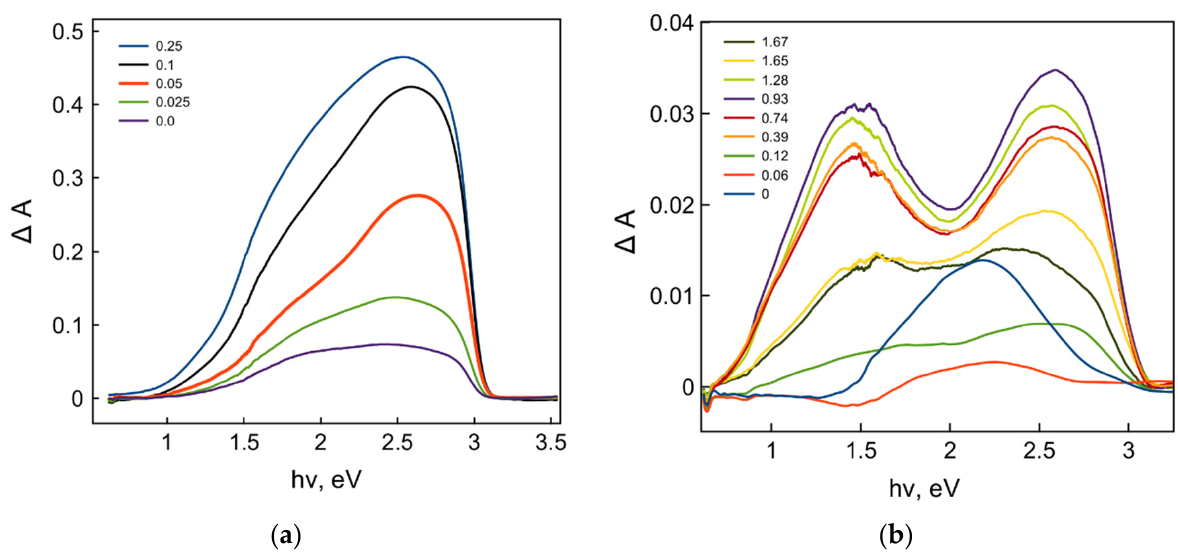
Figure 4. Absorption spectra of photoinduced defects generated for 20 min for the TiO 2 samples with different dopant concentrations: ( a ) Sc 3+ and ( b ) Nb 5+ .